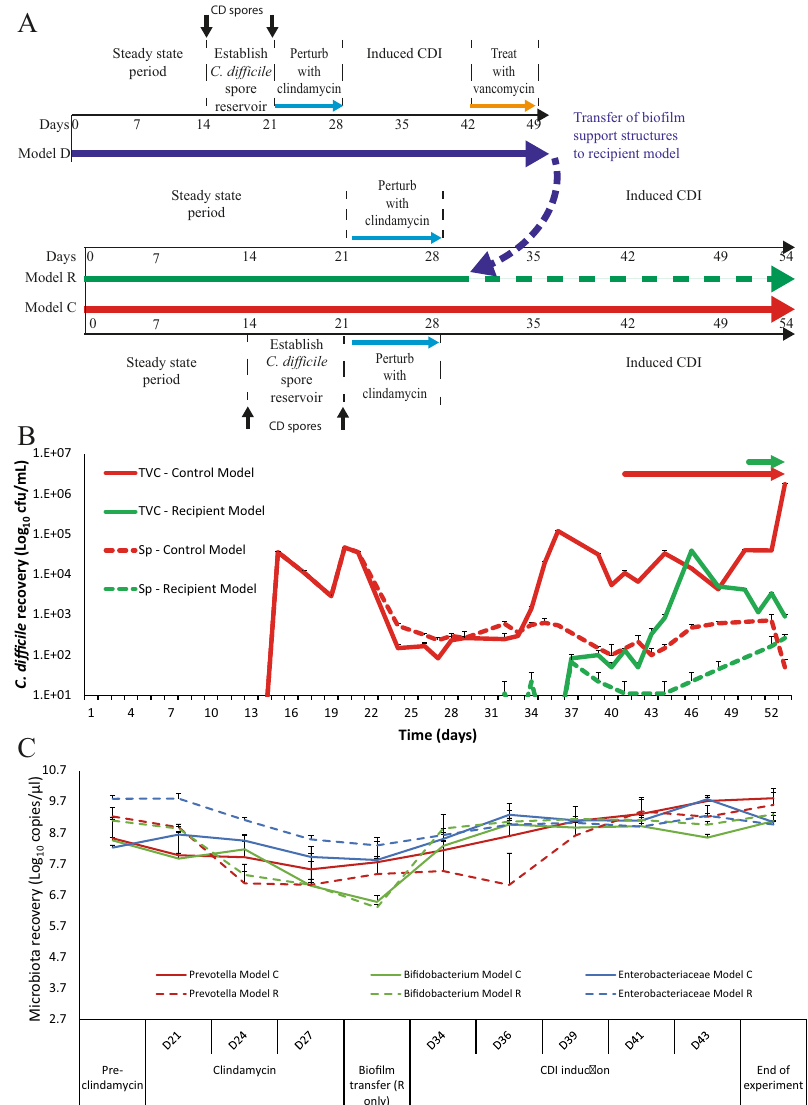
Fig. 3 Contribution of bio fi lm-associated C. dif fi cile to cause recurrent disease. A Timeline of events from the bio fi lm donor model (Model D, blue arrow) prior to support structure transfer, and two further models; a control model (Model C, red arrow) inoculated with C. dif fi cile spores, and a bio fi lm recipient model (Model R, green arrow), which did not receive spores, but received the bio fi lm support structures from model D (broken blue arrow). B Recoveries of luminal C. dif fi cile (total viable counts – TVC; spores - Sp) from model C (red line) and model R (green line) and subsequent periods of toxin detection (arrows). Solid lines are C. dif fi cile total viable cells and broken lines are spore recoveries. Results expressed as mean log 10 cfu/mL from two biological replicates. C Quantitative PCR enumeration of selected luminal microbiota populations from model C (whole lines) and model R (dotted lines) immediately prior to clindamycin instillation (pre-clindamycin), during clindamycin therapy and throughout CDI development and progression. Results expressed as mean log 10 copy number per μL of luminal fl uid from two biological replicates. All error bars represent the standard